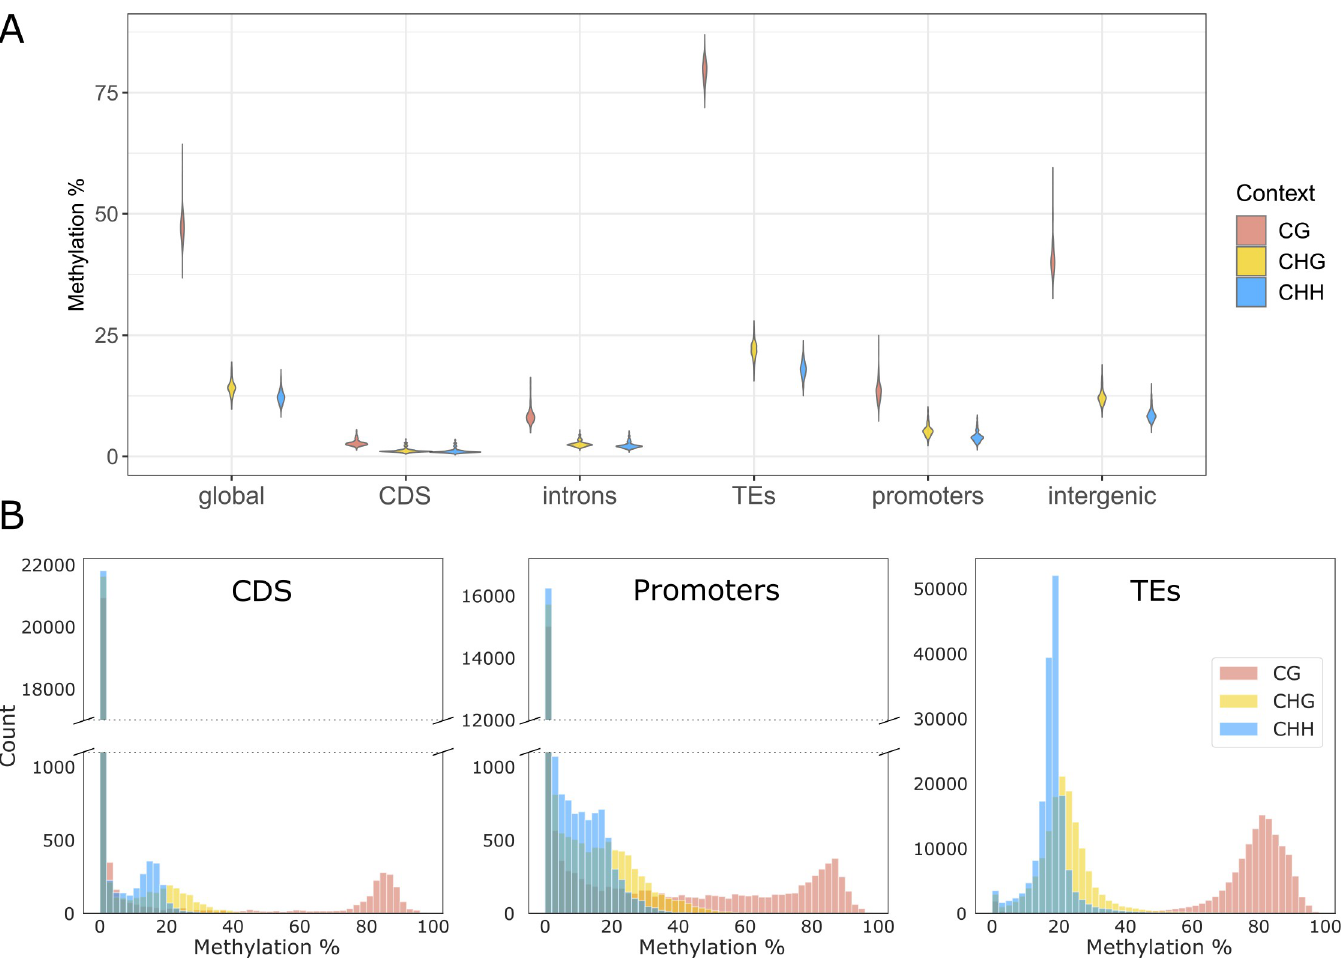
Fig 2. Average methylation and distributions of methylation values for different sequence contexts and genomic features in T . arvense . (A) Weighted average methylation levels of genomic features; violin plots represent variation between lines. (B) Distributions of individual methylation values for coding sequences (CDS), promoters and transposable elements (TEs) obtained averaging across all 207